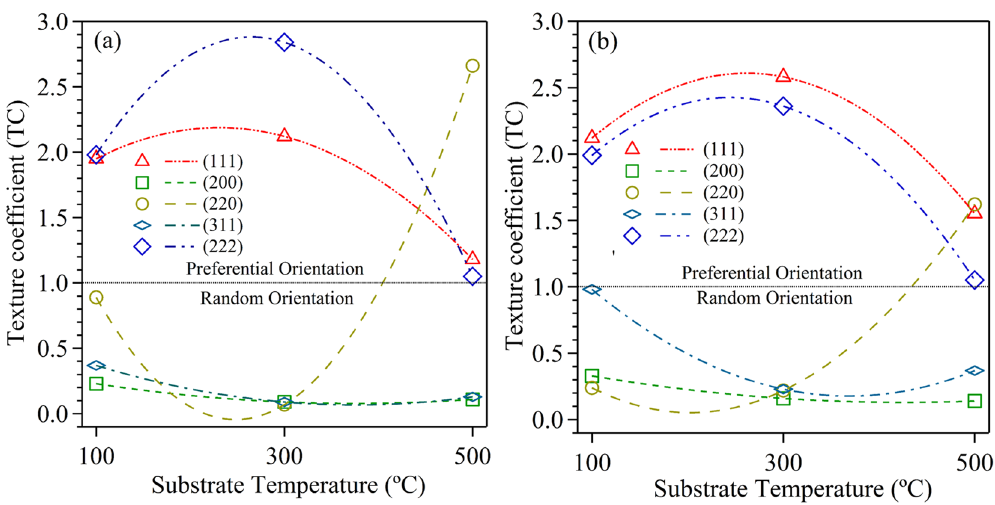
Figure 2. Texture Coefficient of the thin film with respect to the thin film deposited at a different substrate temperature ( a ) Quartz and ( b )